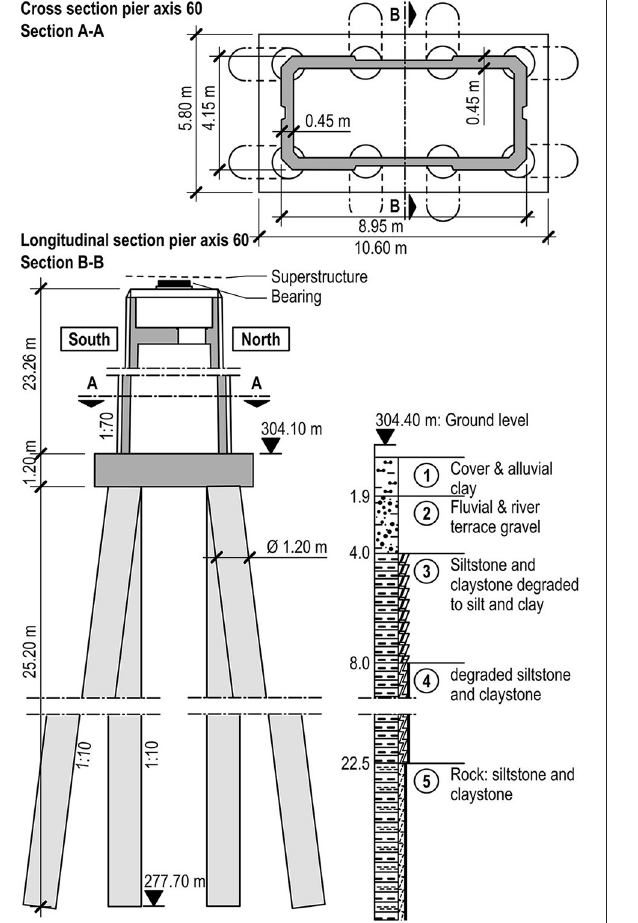
- Measurement of the relative longitudinal displacements and rotations of the structure, using six displacement sensors in each of the eight joints of the superstructure. - Determination of the absolute pier head displacement through geodetic measurements, using a tachymeter and